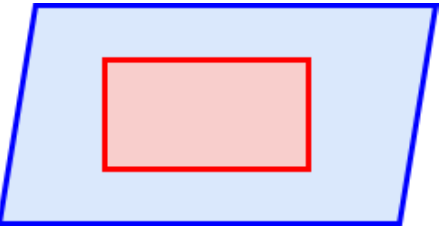
Figure 20. A 20 pixel wide patch used in Poisson editing. The outer blue boundary, in dark blue, and outer red boundary, in dark red, are used as boundary limits of the Poisson equation. The value of the pixels on the blue patch are assigned by computing the mean pixel values of the image that corresponds to the patch. Pixels on the red patch are given the same value as of the correspondent pixel in the image. Adapted from